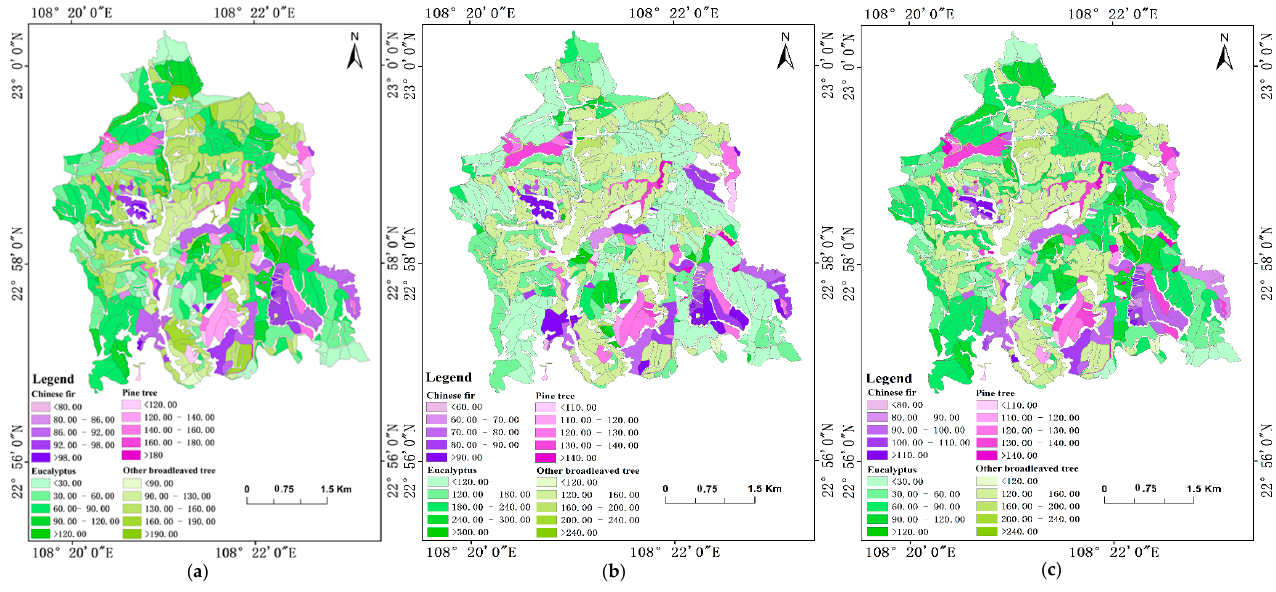
Figure 6. Distribution of forest AGB in the study area based on different data sources (( a ) is the AGB map of each tree species based on airborne LiDAR data. ( b ) is the AGB map of each tree species based on airborne hyperspectral data. ( c ) is the AGB map of each tree species based on feature fusion.).